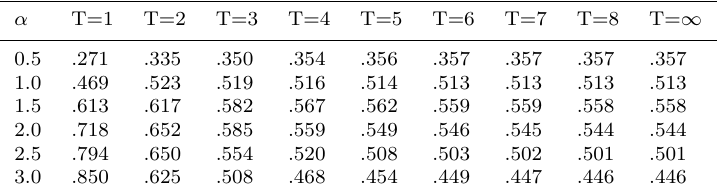
Table 3. Comparison of P T ( D = 1) with P ∞ ( D =